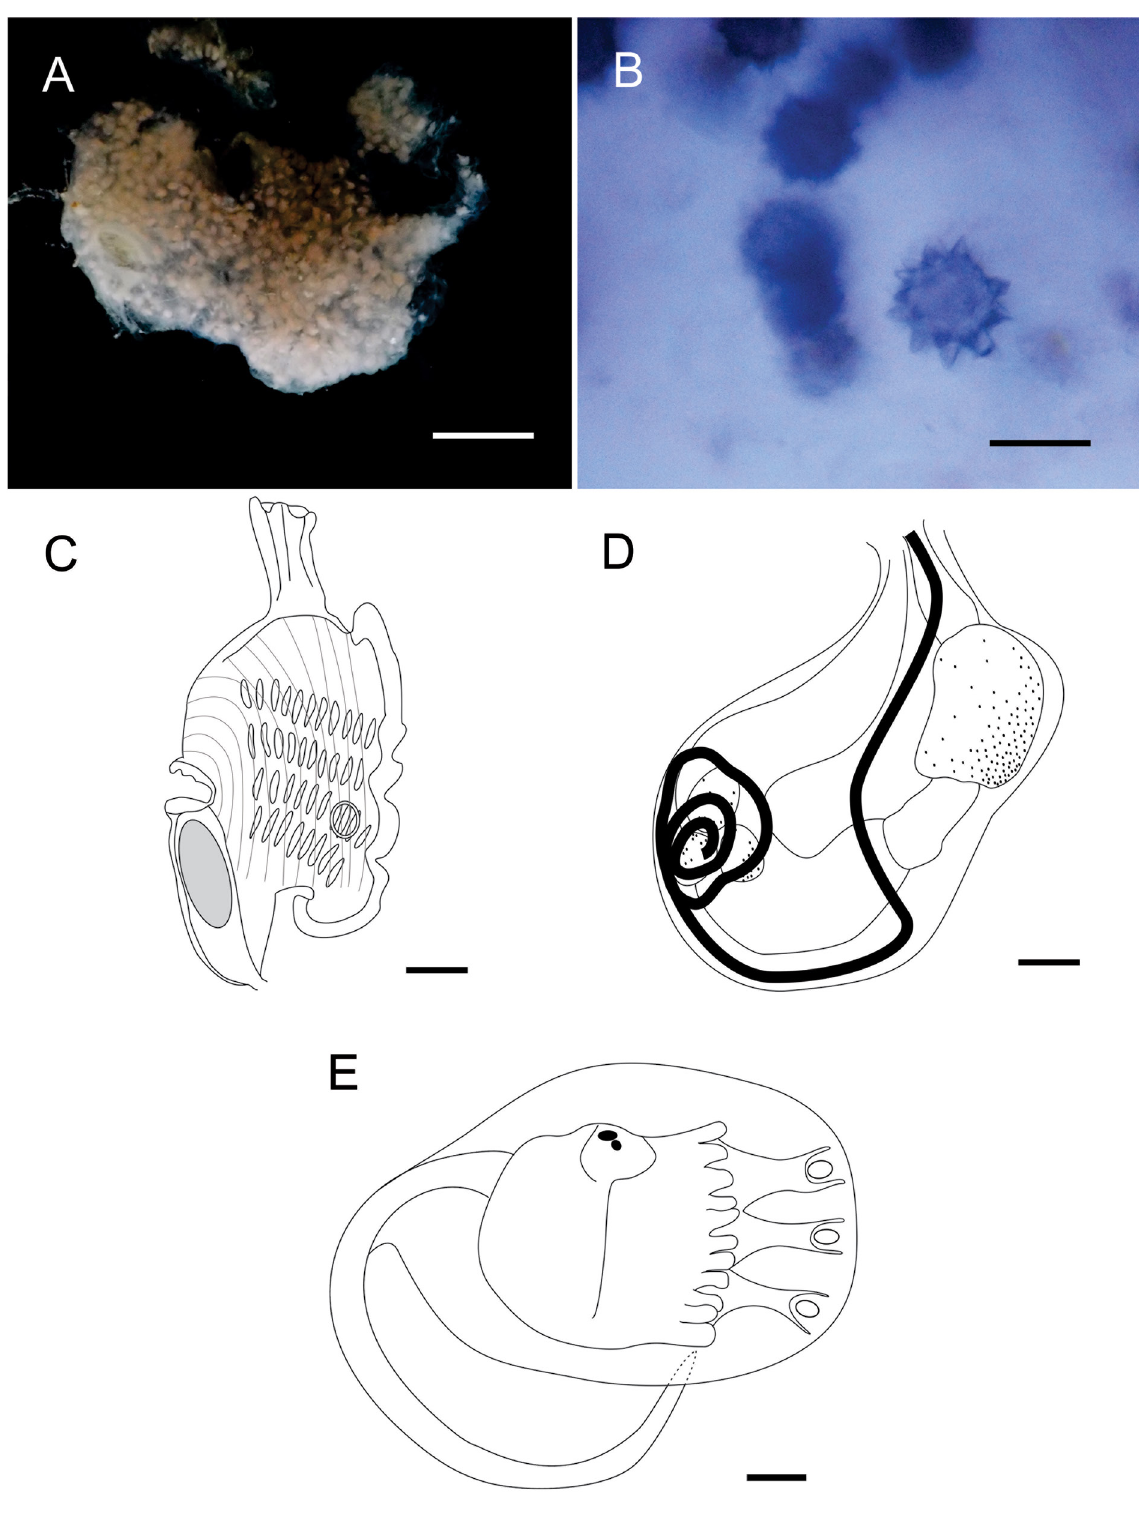
Fig. 3. Leptoclinides lotufoi sp. nov., holotype (ColBio Tun 1245). A . Preserved colony. B . Spicules under light microscope. C . Thorax. D . Abdomen. E . Larva. Scale bars: A = 0.5 cm; B = 30 µm; C–E = 0.1